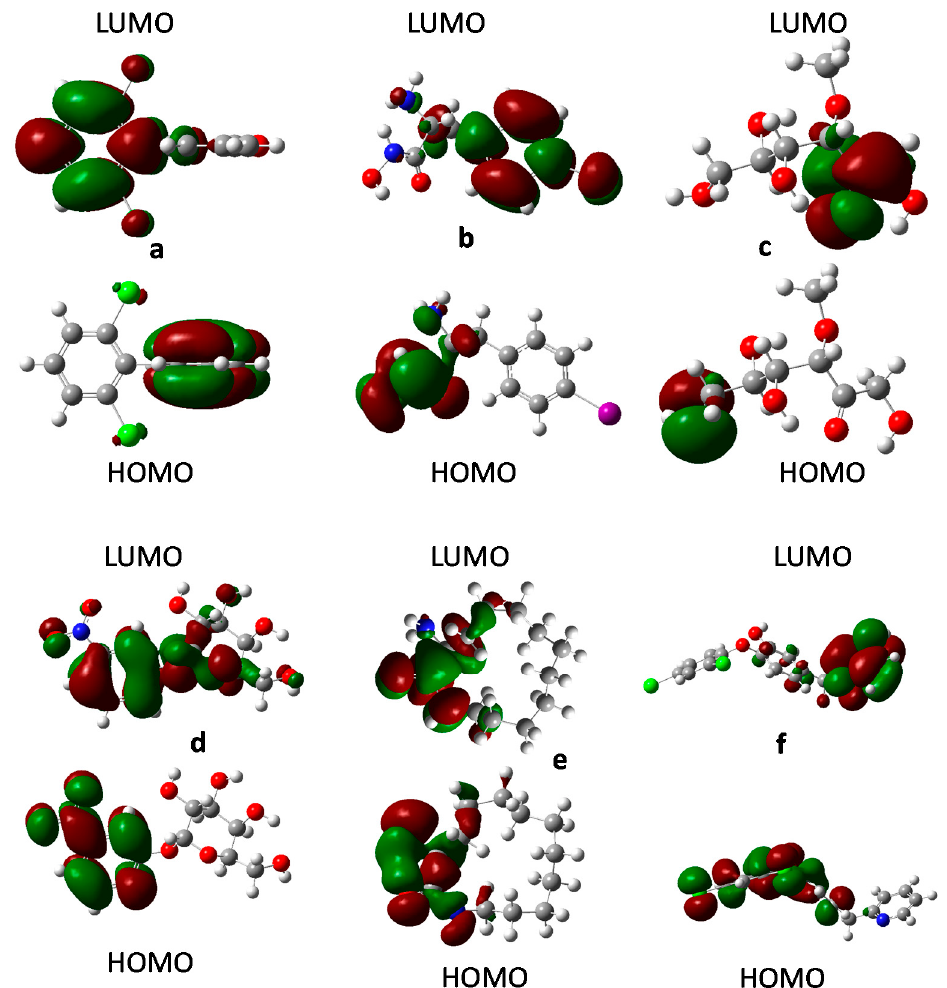
Figure 15. Frontier orbital for ( a ) DB03259; ( b ) DB01980; ( c ) DB02438; ( d ) DB02213; ( e ) DB08476; ( f ) DB07287.